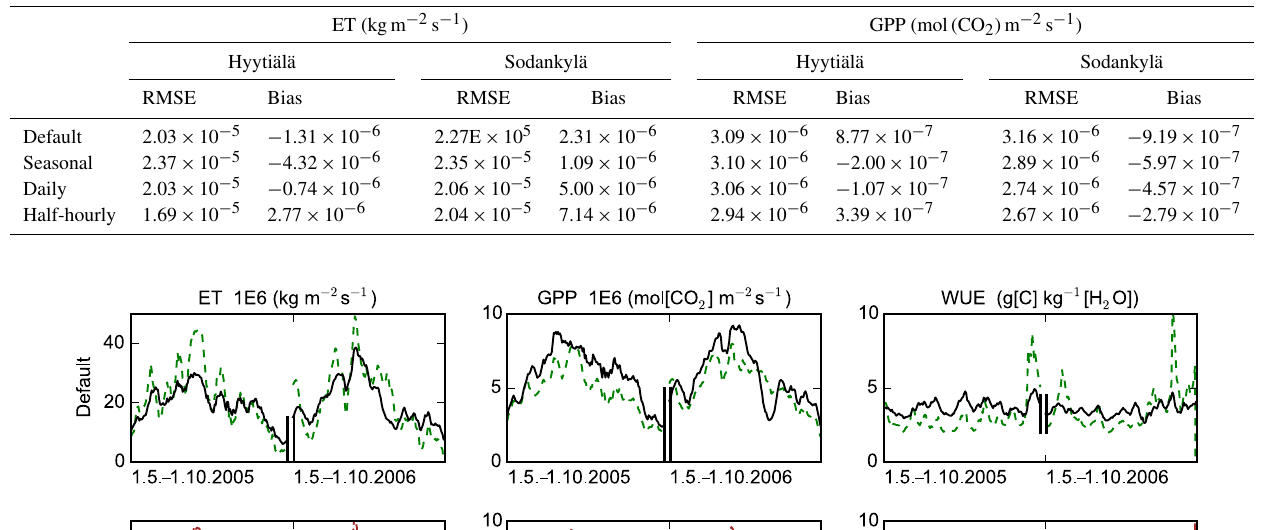
Table 6. RMSE and bias of ET and GPP calculated from half-hourly data for first two summers of the validation period for Hyytiälä (corresponding to Fig. 2) and last two summers of the validation period for Sodankylä (corresponding to Fig. 3).